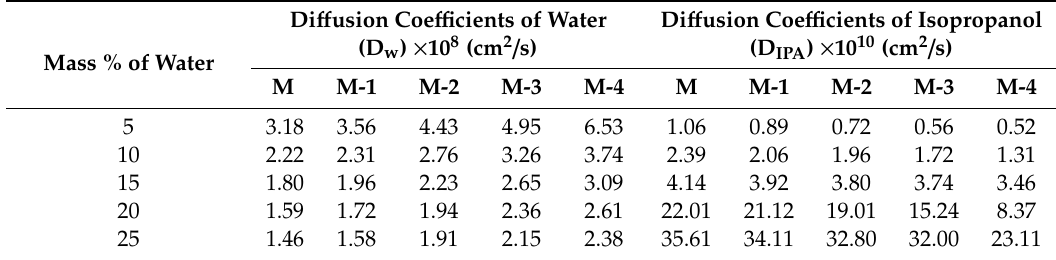
Table 3. Di ff usion coe ffi cients of di ff erent membranes for water and isopropanol at di ff erent mass% of water in the feed.